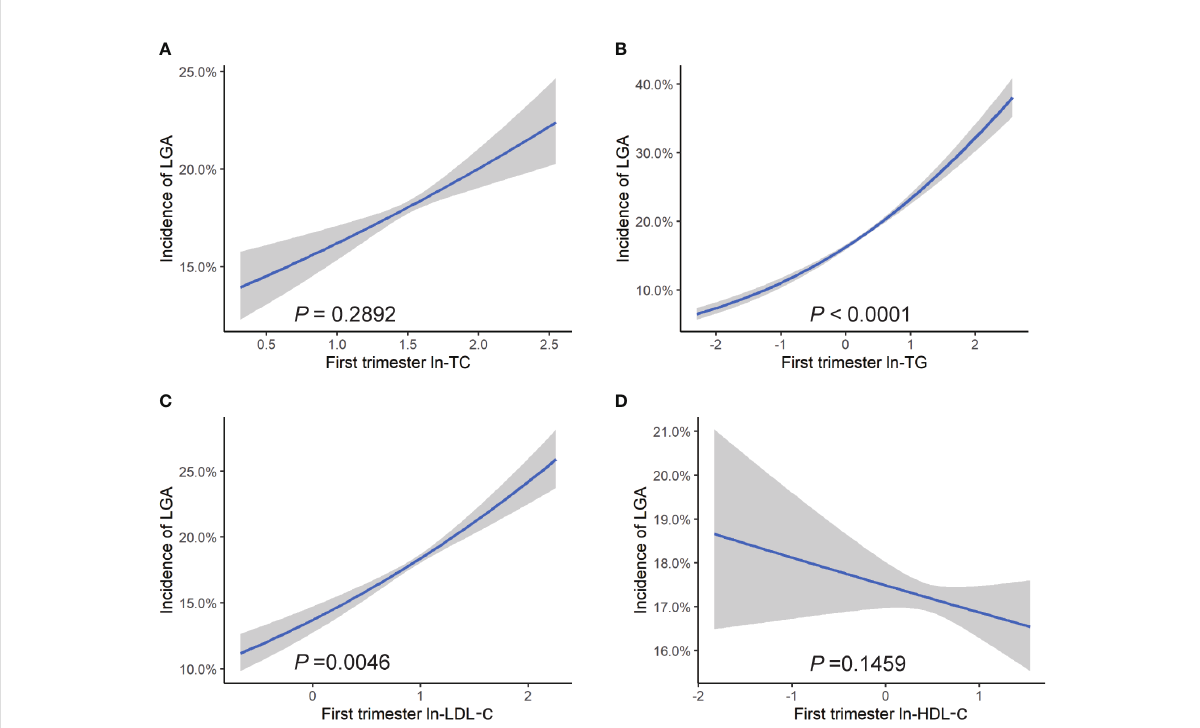
FIGURE 3 Risk of LGA associated with maternal lipid pro fi les in early pregnancy. Logistic regression models for ln transformed (A) TC, (B) TG, (C) LDL-c, (D) HDL-c, and LGA, expressed as predicted mean with 95% CIs. Analyses were adjusted for maternal pre-pregnancy BMI, age, mode of conception, parity, education, consumption of cigarettes, infant sex, gestational diabetes, and gestational hypertension disorders.